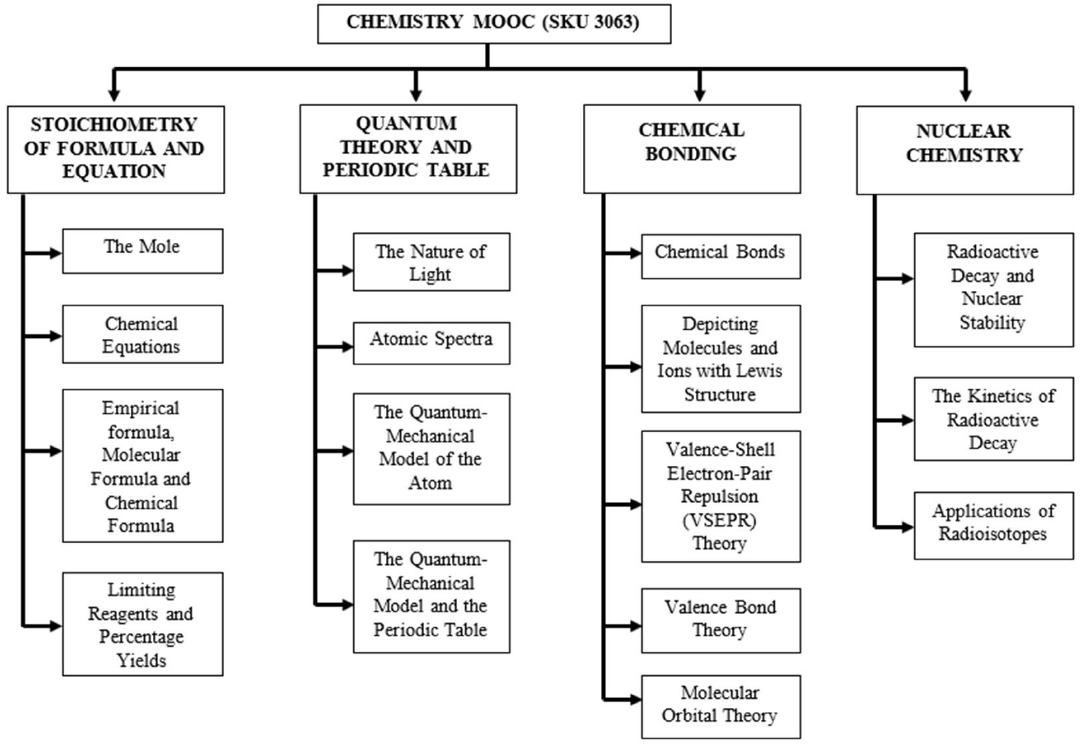
Figure 4. Structure of the topics for the e-content module (Hamid, 2020)